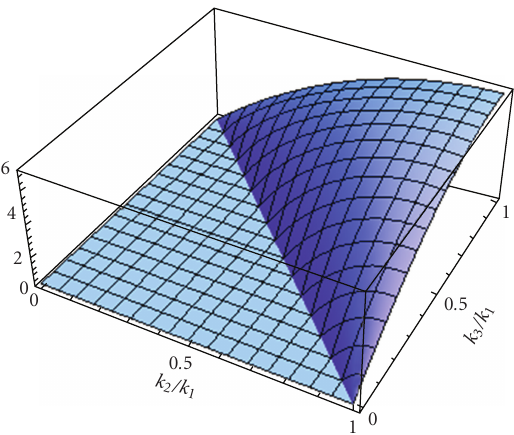
Figure 5: An ansatz (127) for the equilateral